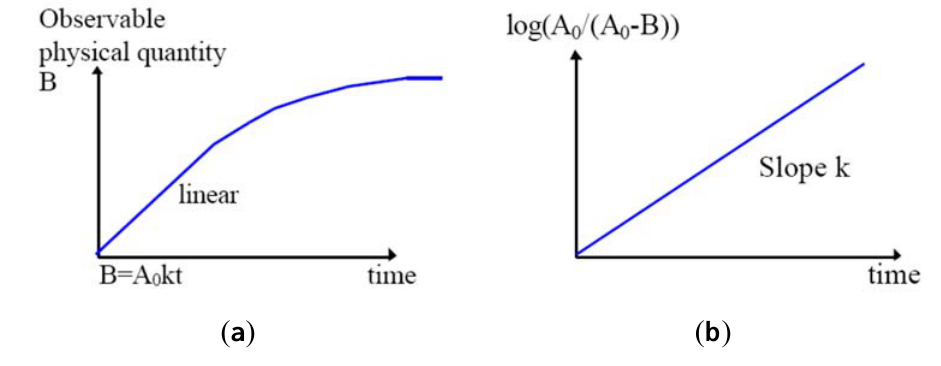
Figure 16. SIREPA. ( a ): B vs. time; ( b ): log(A 0 /(A 0 − B)) vs.